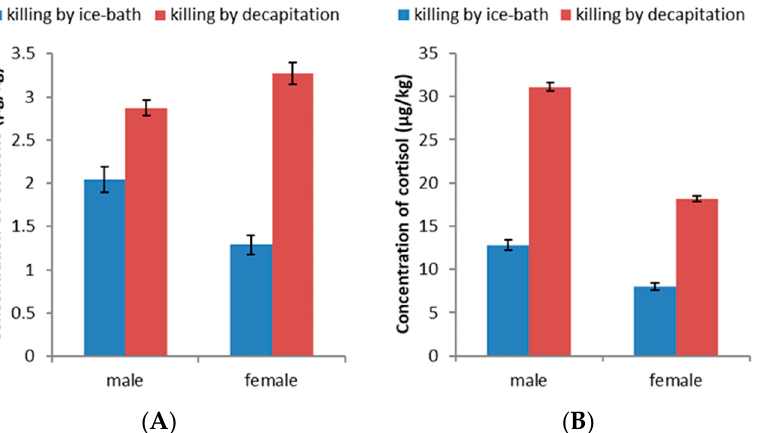
Figure 1. The concentrations of cortisone ( A ) and cortisol ( B ) in Zebrafish killed by different killing methods.